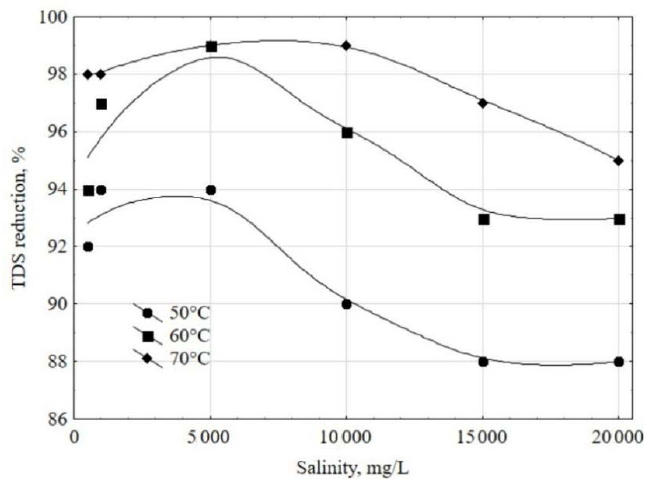
Figure 9. Percentage reduction of total dissolved solids (TDS) in treated water as a function of the salinity of the feed water of the bench ‐ scale ultrasonic prototype for boiler water treatment.